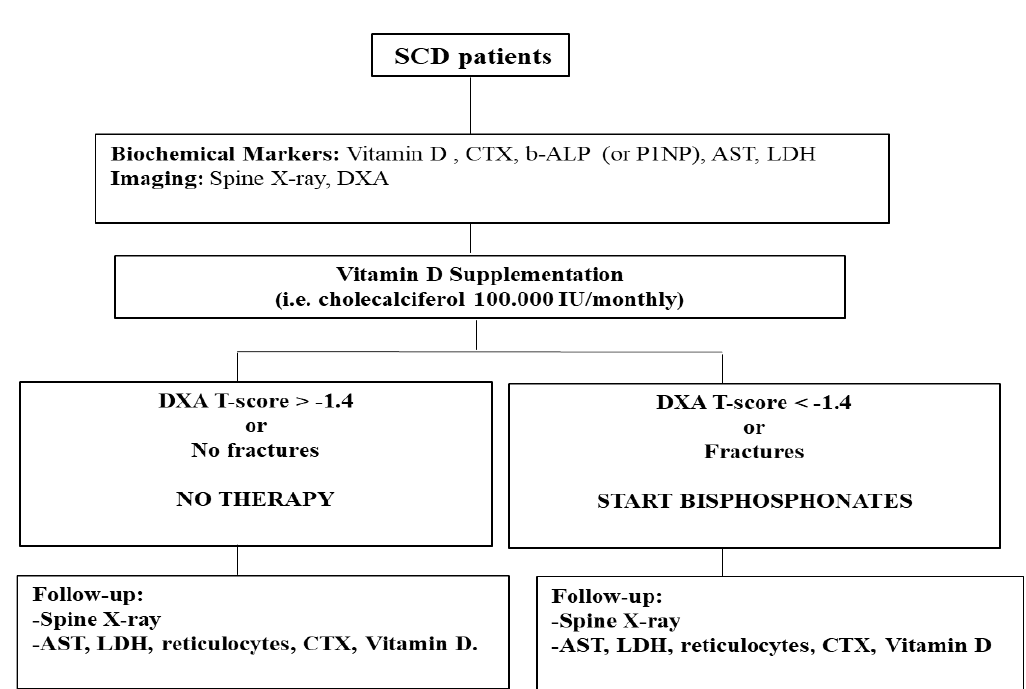
Figure 5. Algorithm for clinical management of sickle cell bone disease. CTX: carboxy-terminal collagen crosslinks; b-ALP: bone alkaline phosphatase; P1NP: procollagen type 1 N-terminal propeptide; AST: aspartate aminotransferase; LDH: lactate dehydrogenase; DXA: dual x-ray absorptiometry; SCD: sickle cell